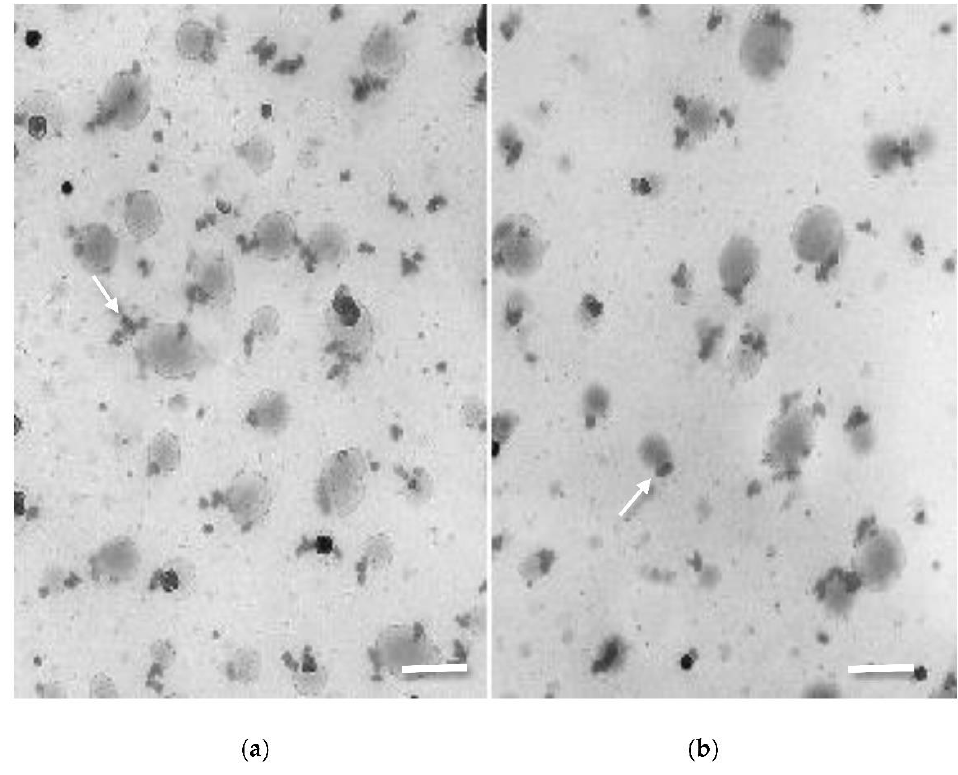
Figure 1. TEM images of ( a ) chitosan nanoparticles (CHT-NPs) and ( b ) CHT-NPs-N-acetyl cysteine (NAC) showing the presence of particles of 35–40 nm (arrows), aggregating to form larger particles of 150–200 nm (bars = 200 nm).